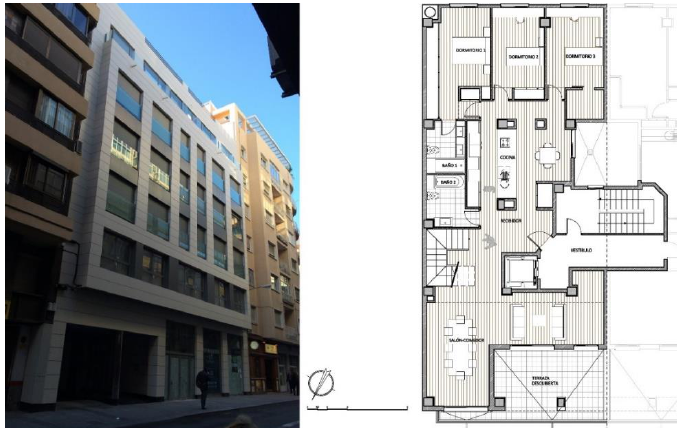
Figure 1. Image of the main façade of the housing block and floor